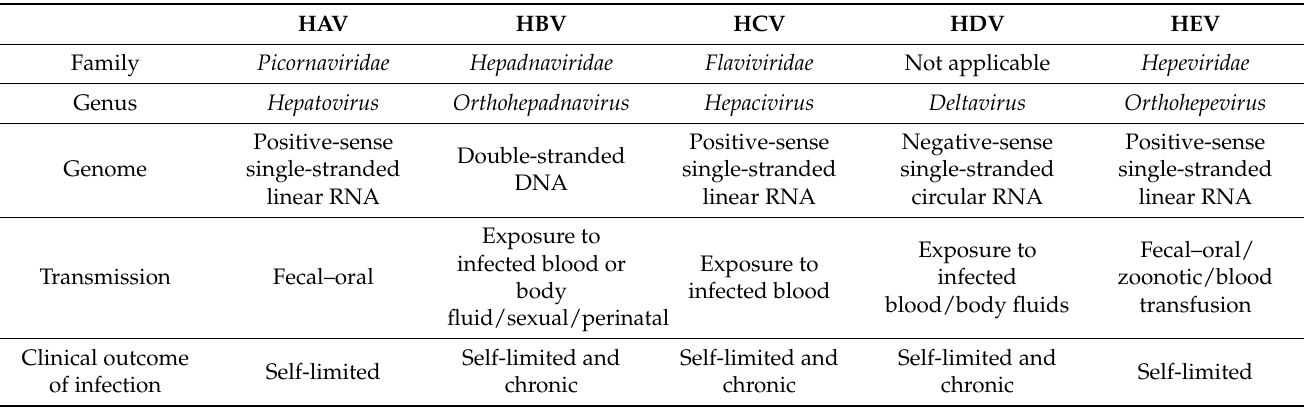
Table 1. Characteristics of hepatitis